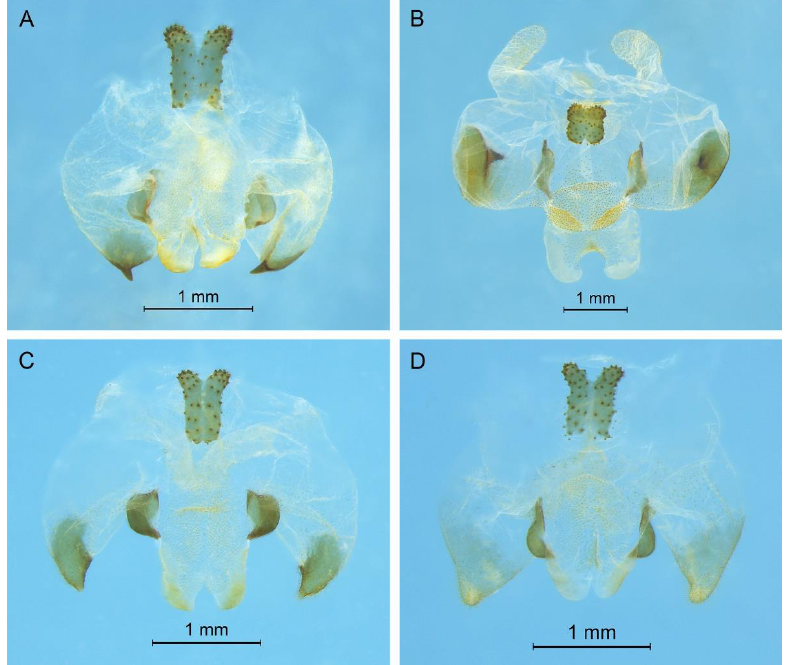
Figure 3. Male genitalia of Gymnaetoides . ( A ) Gymnaetoides huangshanensis Zhu & Shi sp. nov.; ( B ) Gymnaetoides petalus Zhu & Shi sp. nov.; ( C ) Gymnaetoides yangmingensis Zhu & Shi sp. nov.; ( D ) Gymnaetoides lushanensis Zhu & Shi sp. nov.